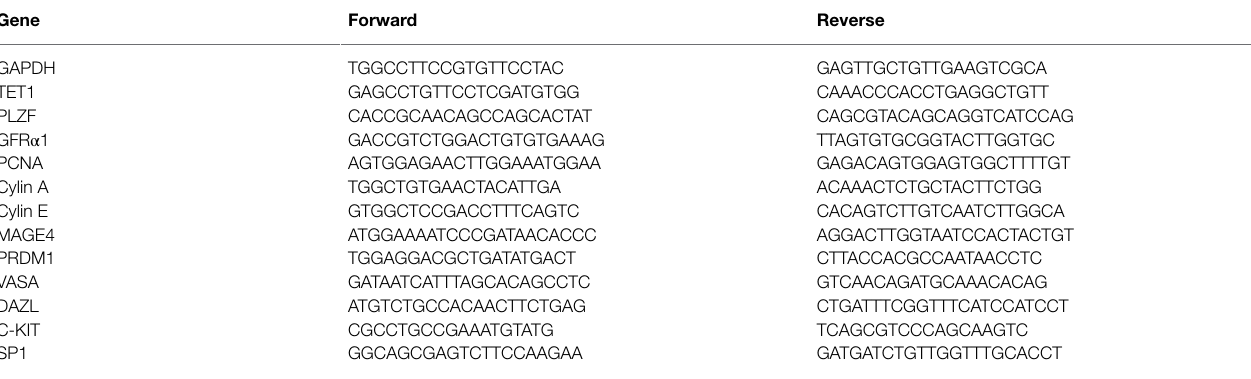
TABLE 1 | QRT-PCR primers. Gene Forward Reverse